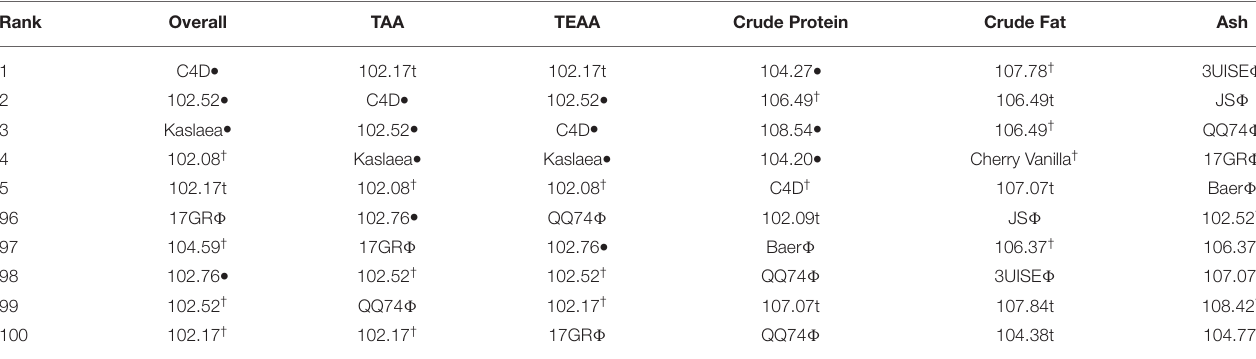
TABLE 7 | The five highest and lowest ranking samples are presented for overall rank (all nutritional components combined), total amino acids (AA), total essential AA (TEAA), crude protein, crude fat, and